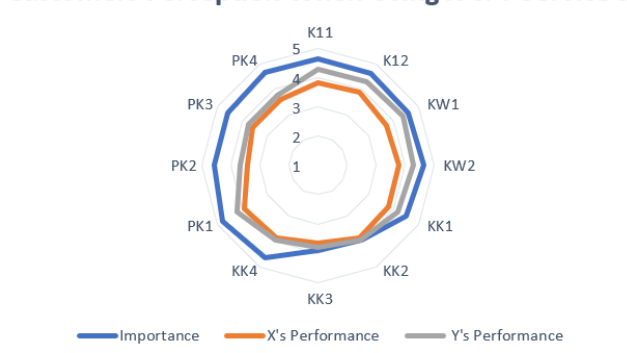
Figure 2. Visualization of SIPA analysis.